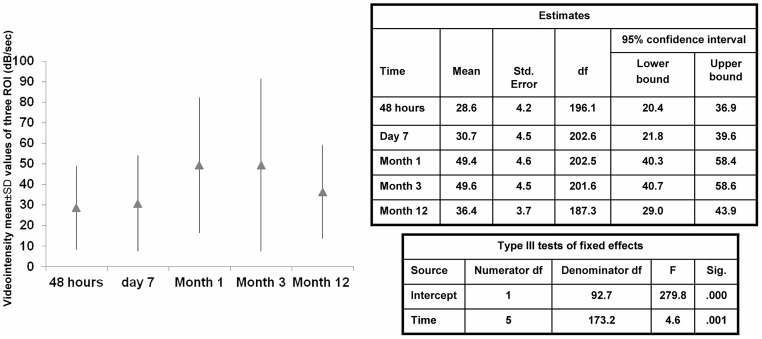
Estimated CCBF mean values of the 79 patients studied at various times after transplantation.It is notable that the CCBF starts at lower levels than those that will be reached at months 1 and 3 (this peak varies among patients). It is also remarkable that, after 12 months, CCBF values decrease significantly, remaining at an intermediate level between the initial and maximum values.